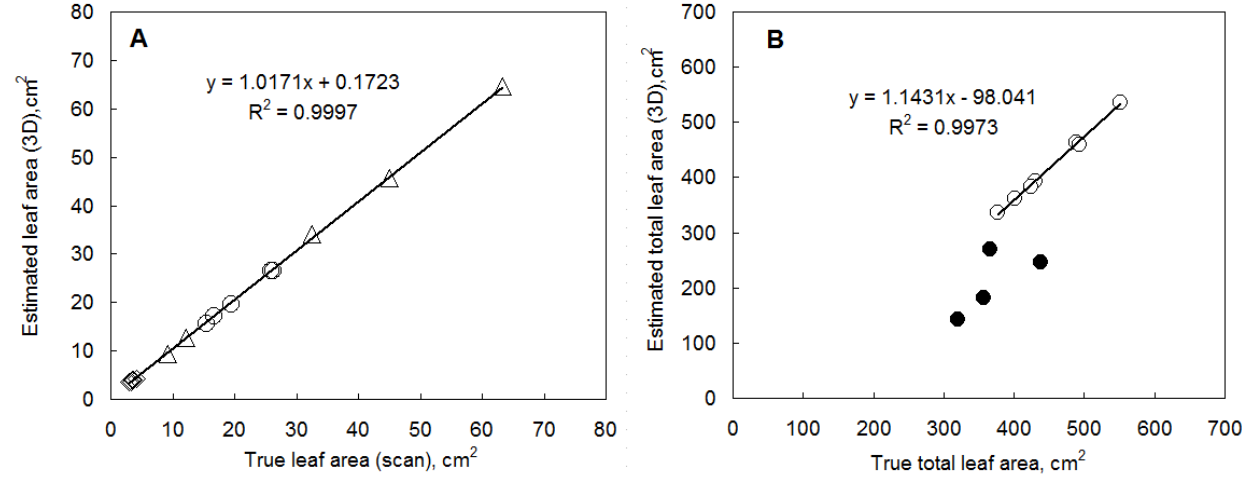
Figure 4. Comparison of direct measurement of plant leaf area with the area determined from the 3D computer reconstruction. (A) Measurement of individual leaves that differed in their size and morphology (bean [ ◊ ], cycad [ ○ ] and hibiscus [ Δ ]). The leaves were attached to plants in their natural position. (B) Measurement of total leaf area of whole pepper plants that differed in their cultivation conditions: well watered plants cultivated in high and low light (450 and 85 μ mol (photons) m − 2 ·s − 1 of photosynthetically active radiation, respectively) [ ○ ] and water stressed plants in high light [ ● ]. The lines represent a linear regression optimized by Microsoft Excel.